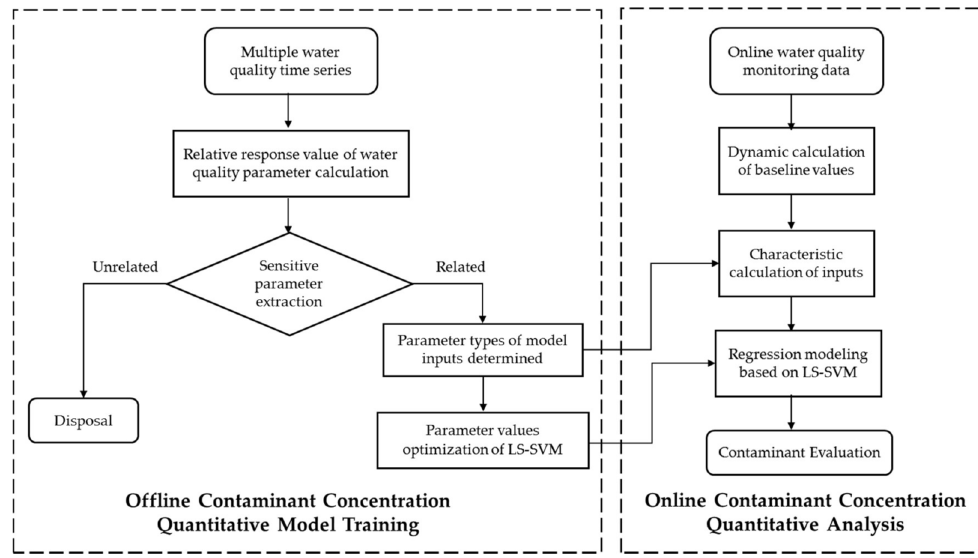
Figure 1. Schematic of a method for quantitative analysis of contaminant concentration using